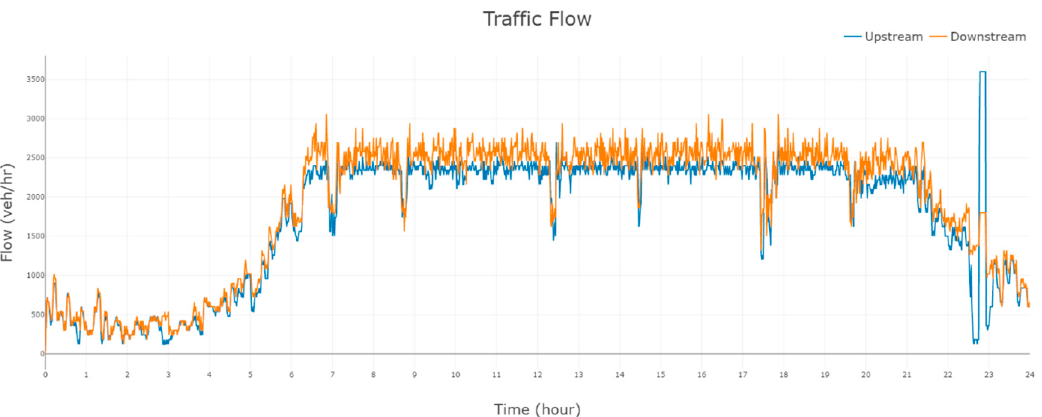
Figure 13. Tra ffi c flow measured upstream and downstream of the ramp—ALINEA metering Figure 13. Traffic flow measured upstream and downstream of the ramp—ALINEA metering scenario.